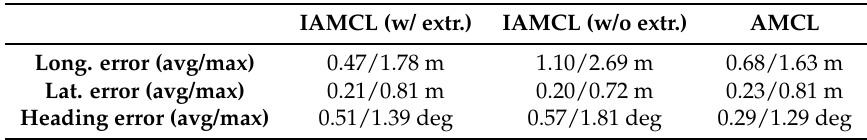
Table 2. Comparison between the average longitudinal, lateral and heading average errors of the localization stack using IAMCL (with and without extrapolation) or